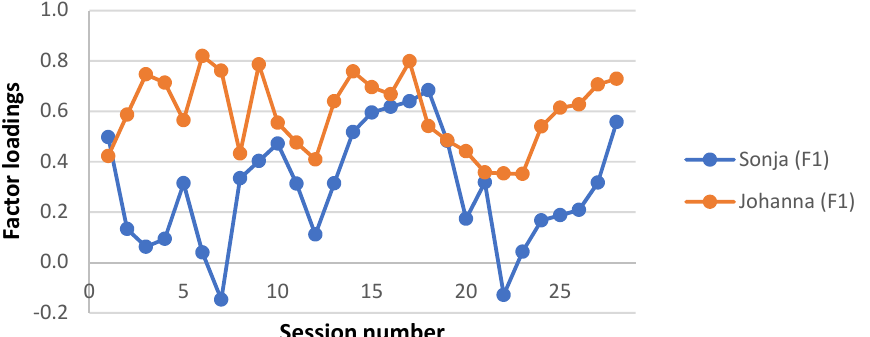
Figure 1. Interaction structure 1: “Making sense of relationships”. Factor loadings on each session for Sonja and Johanna.